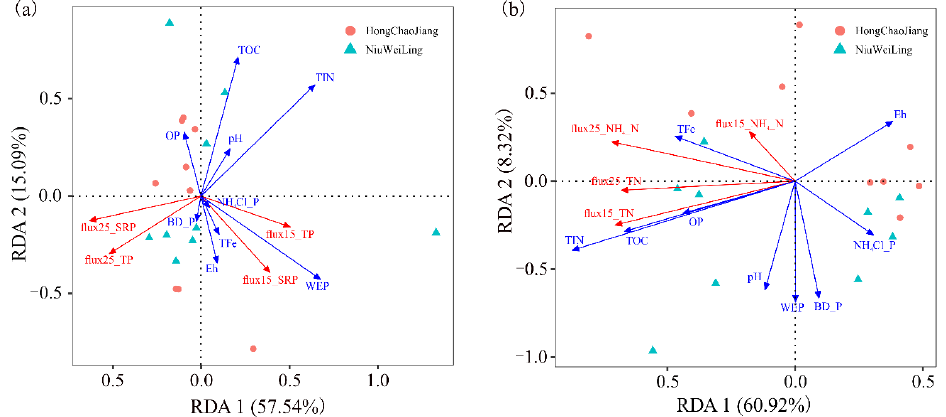
Figure 7. Redundancy analysis (RDA) used to identify the main controlling factors of sediment